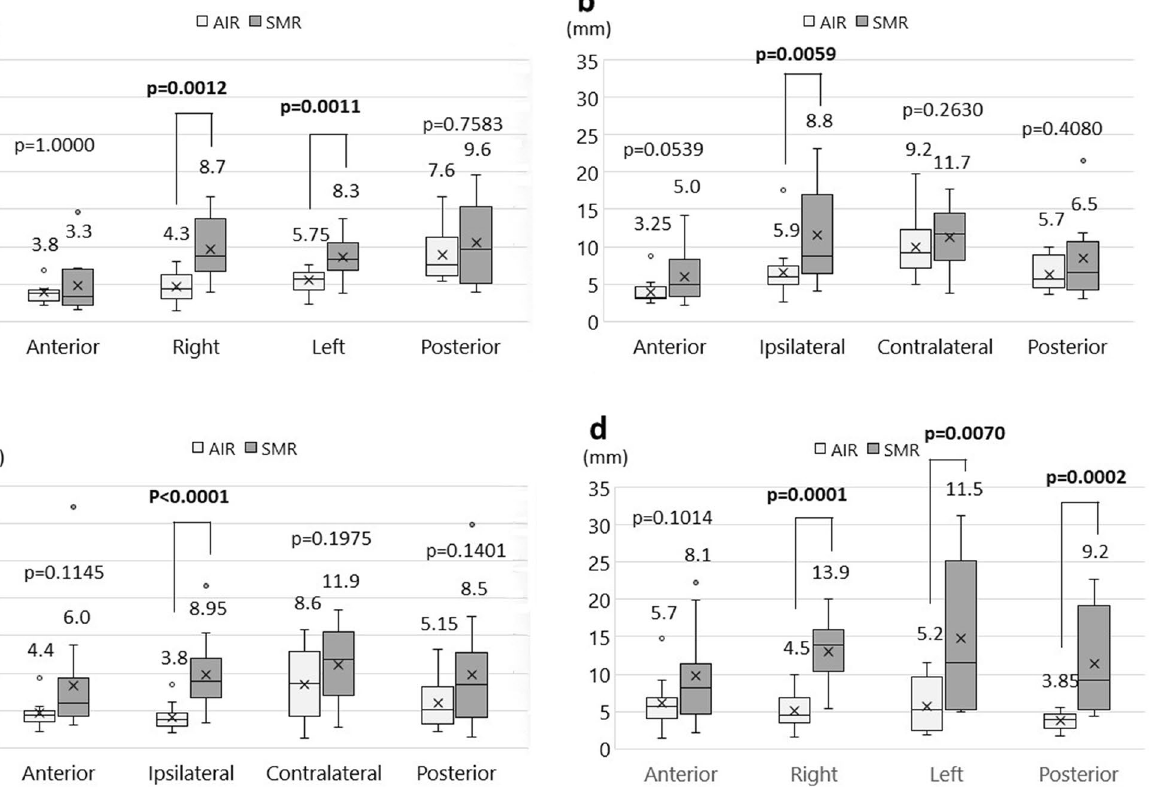
Figure 4. Distance errors of fiducial markers in each surgical position. ( a) supine position (without head rotation); ( b) supine position with head rotation; ( c) lateral position; ( d) prone position. Box plots show the median values with 25th and 75th quartiles. The whisker plots show the maximum and minimum values. The “X” shows the average